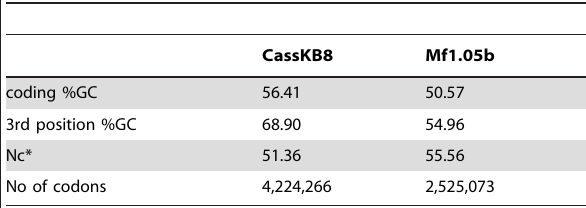
Table 3. GC content in predicted coding regions of genes with BLASTX e-values , 10 2 10